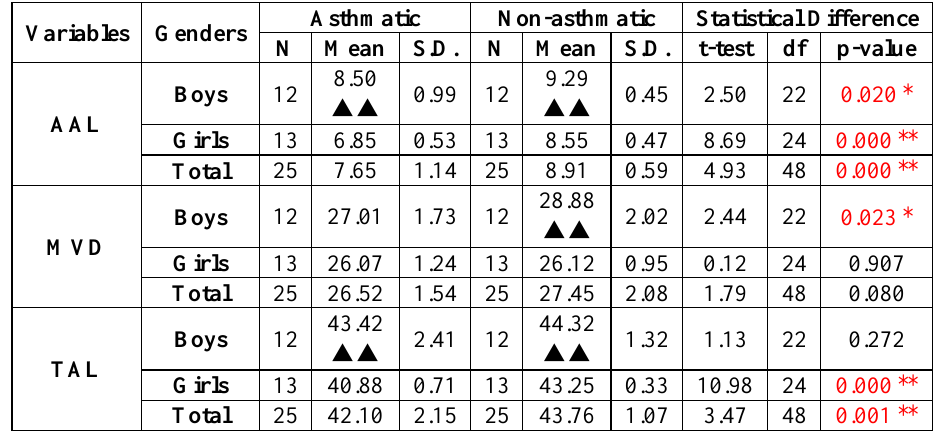
Table 3: Maxillary arch length (mm) among asthmatic and non-asthmatic children by genders Asthmatic Variables Genders